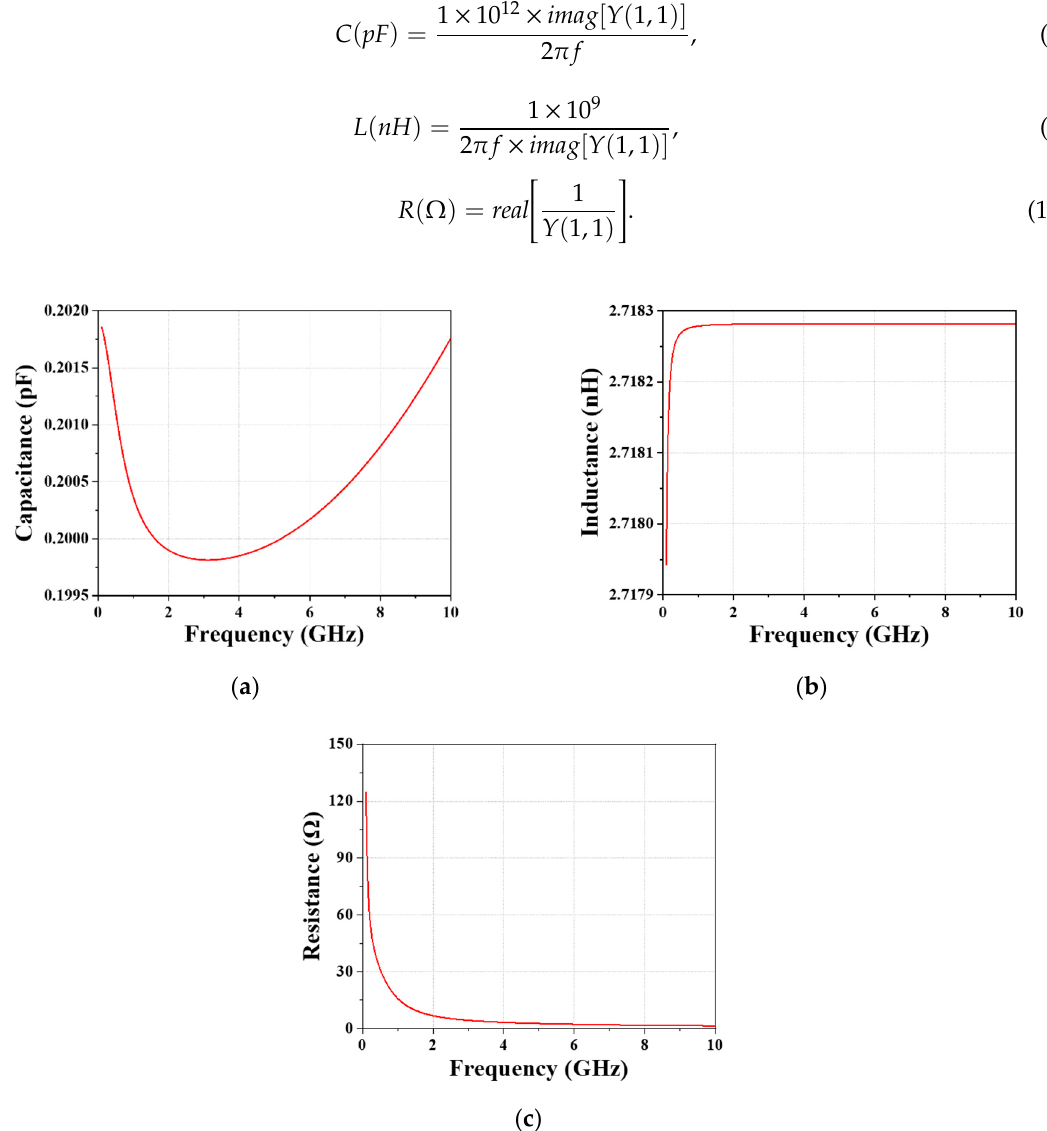
Figure 3. Calculated ( a ) capacitance, ( b ) inductance, and ( c ) resistance of the central capacitor from the Y-parameter in the range of 0–10 GHz.